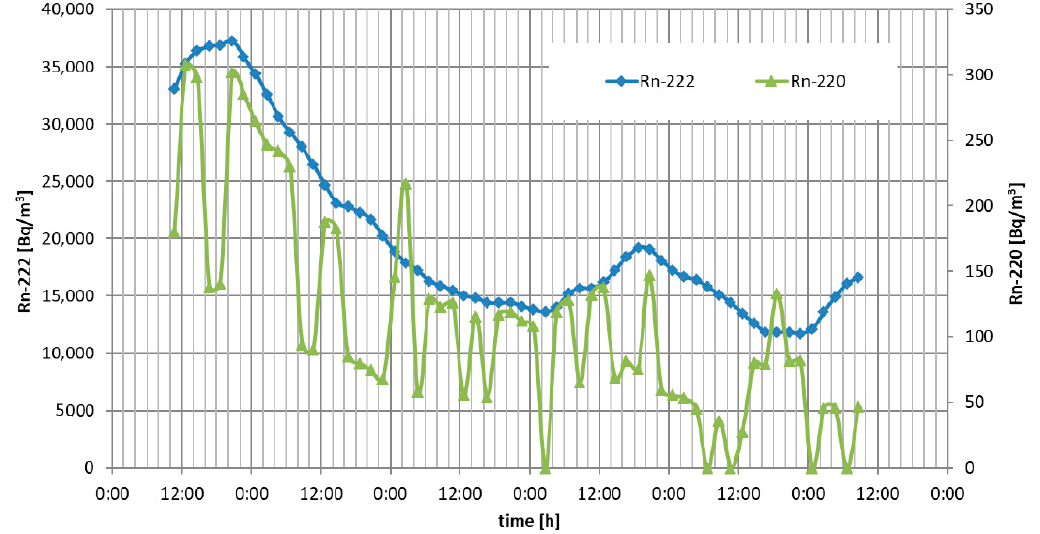
Figure 5. Results of radon (orange) and thoron (green) concentration in the gallery—2nd cam- paign.